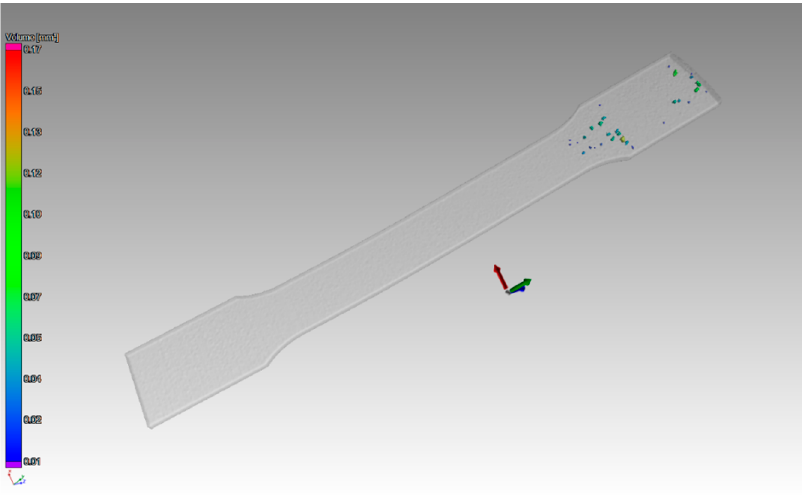
Figure 5. Pores detected in a part, which had a thickness of 1 mm oriented in Z. Identification of defects at selected locations in the sample, which had a thickness of 1 mm and was oriented in the Z direction, is shown in Figure 6.